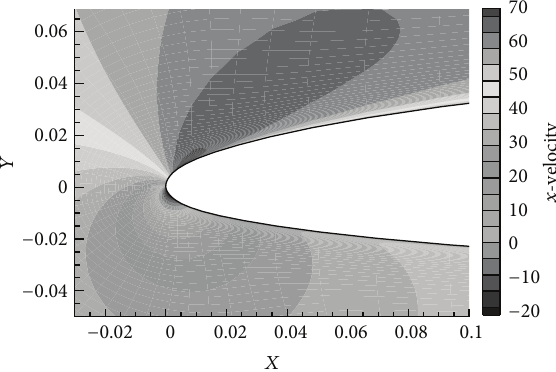
Figure 11: 𝑋 -velocity distribution of air around the original airfoil.